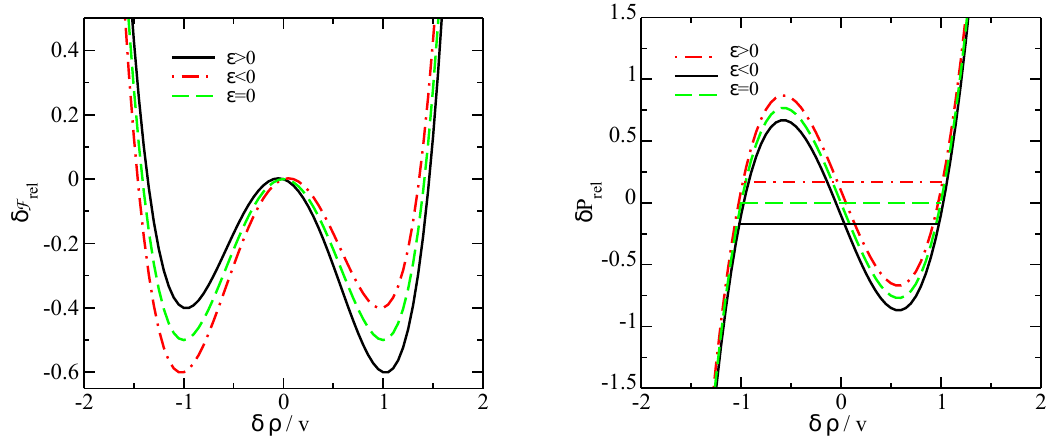
= δ ( T cr , ρ cr ) and the value δ P / F rel F L F L